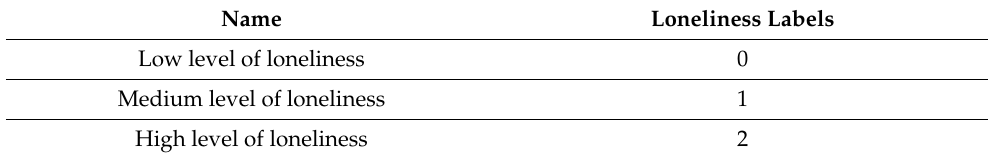
Table 5. Classification